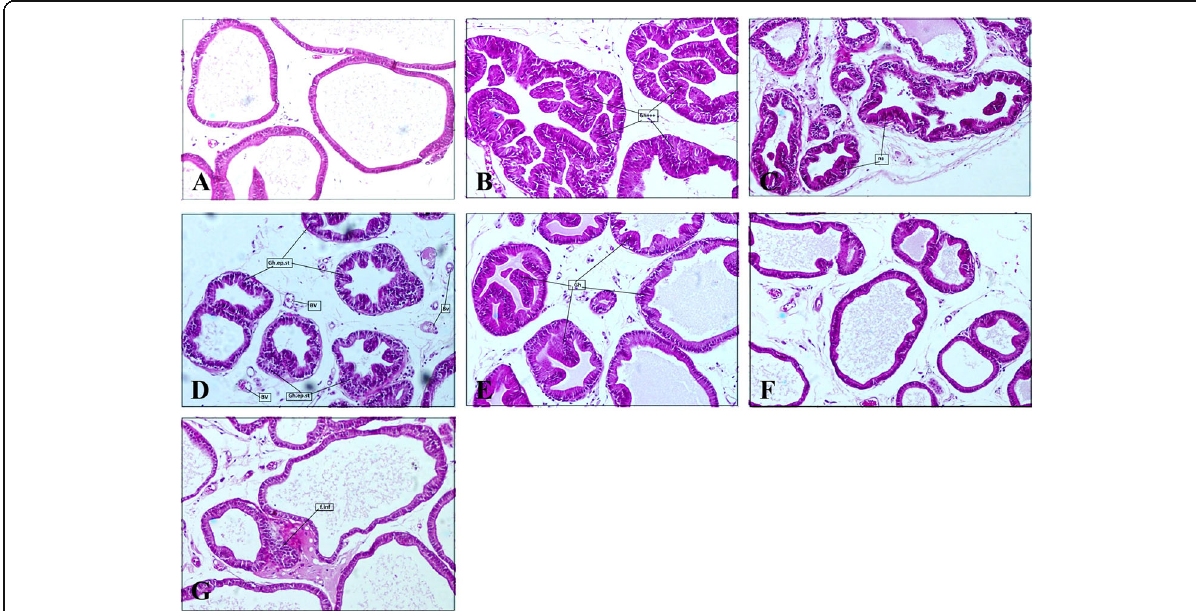
Fig. 4 Effects of VISPO administration on prostate hyperplasia. Prostate tissues were fixed, sectioned at 4 μ m thickness, stained with hematoxylin and eosin (H&E, magnification, × 100). a Vehicle control, b BPH/vehicle, c BPH/SPO 200 mg/kg, d BPH/SPO 400 mg/kg, e BPH/VISPO 200 mg/kg, f BPH/VISPO 400 mg/kg and g BPH/Finasteride 1